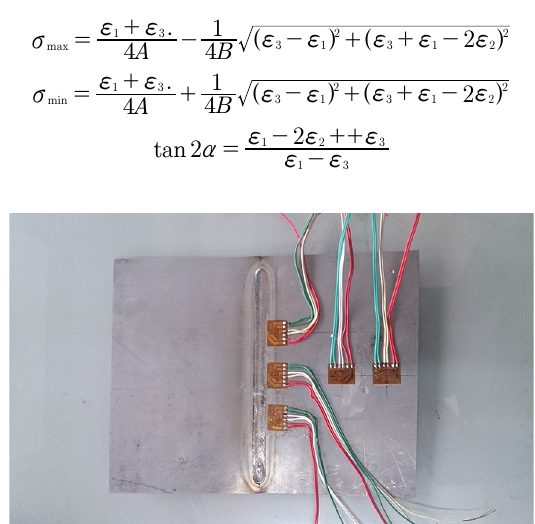
Figure 2. Positions of strain gauges on the thin sheets.